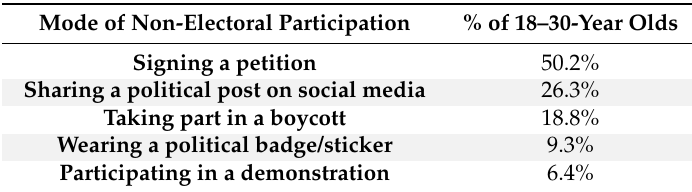
Table 1. Reported levels of youth participation for forms of non-electoral